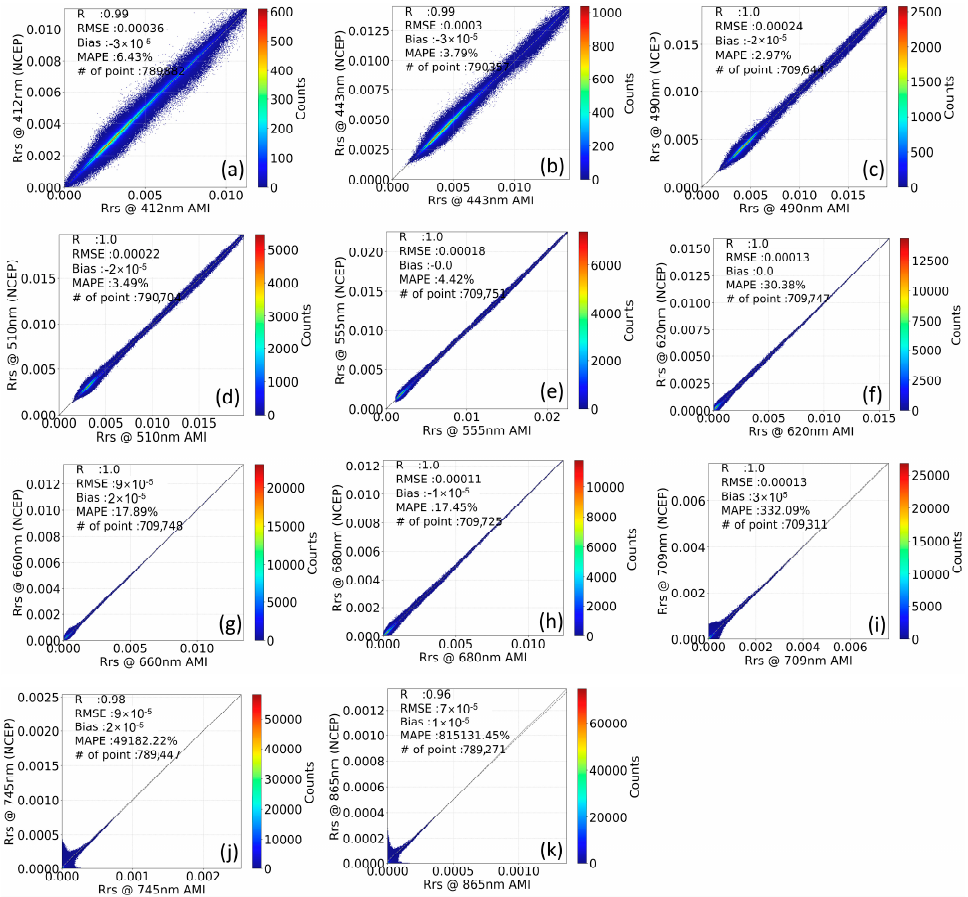
Figure 6. Scatter plots of remote sensing reflectances for ( a ) 412, ( b ) 443, ( c ) 490, ( d ) 510, ( e ) 555, ( f ) 620, ( g ) 660, ( h ) 680, ( i ) 709, ( j ) 745, and ( k ) 865 nm. Solid and dashed lines in each figure indicate the 1:1 and regression lines, respectively.